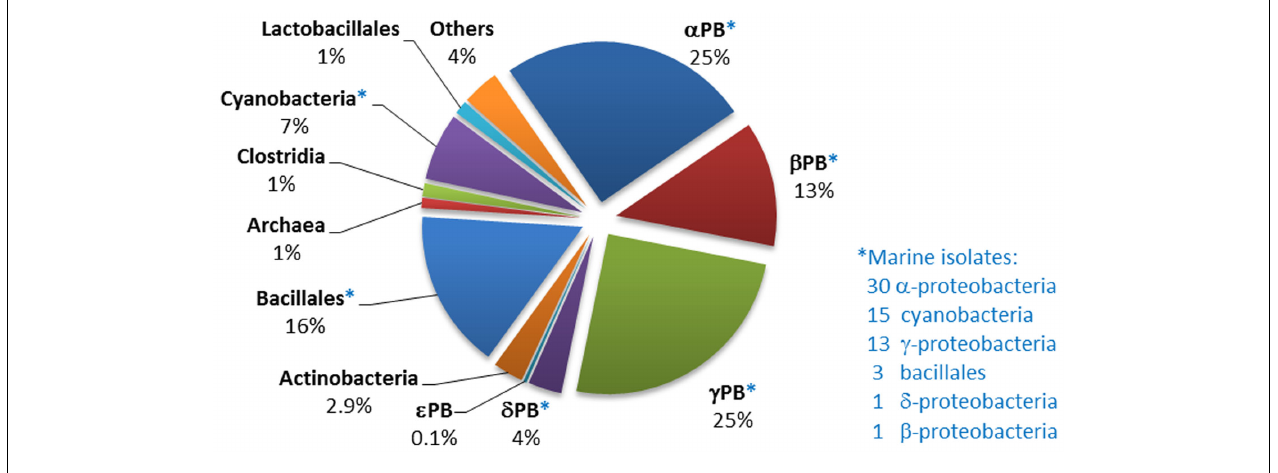
FIGURE 6 | Distribution of phnD homologs within sequenced bacterial genomes. The numbers and affiliations of marine bacterial strains that contain